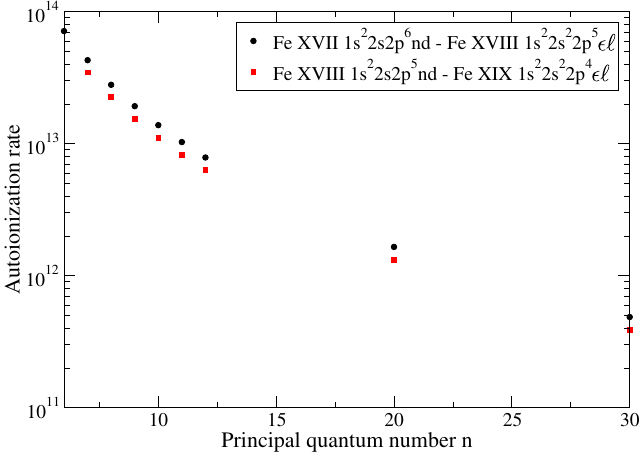
Figure 19. Autoionization rate for Fe XVII 1 s 2 2 s 2 p 6 nd → Fe XVIII 1 s 2 2 s 2 2 p 5 (cid:101) (cid:96) and Fe XVIII 1 s 2 2 s 2 p 5 nd → Fe XIX 1 s 2 2 s 2 2 p 4 (cid:101) (cid:96) , n = 1, 20. Figure 20 represents transition 1 s 2 2 s 2 p 6 6 d − 1 s 2 2 s 2 p 5 4 d 6 d with and without broadening due to autoionization process 1 s 2 2 s 2 p 6 6 d − 1 s 2 2 s 2 2 p 5 (cid:101) (cid:96) computed using FAC code [92]. The gap is slightly